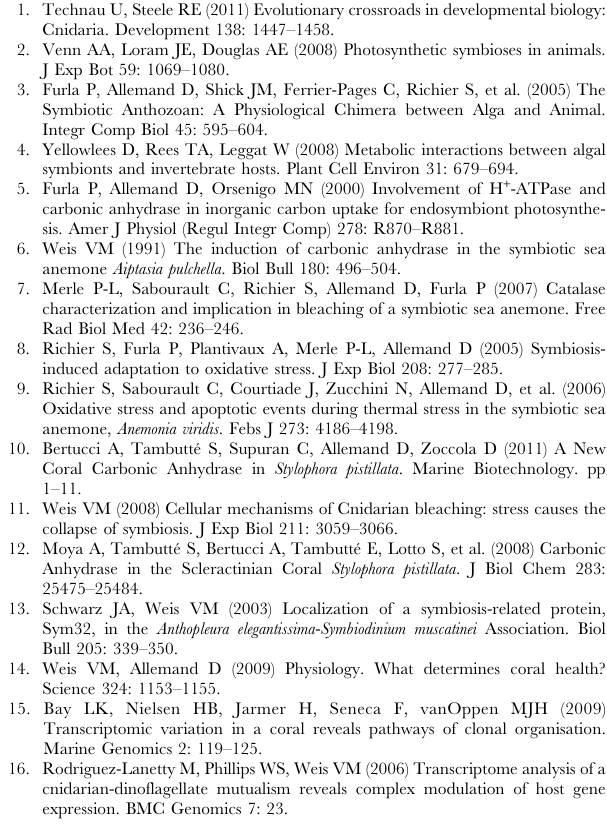
Table S1 List of the genes up-regulated in the Symbiotic condition. Legend as in Table 2. Table S2 List of the genes up-regulated in the Aposymbiotic condition. Legend as in Table 2. Table S3 Primer sequences used in this article. Table S4 Gene sequences used in this